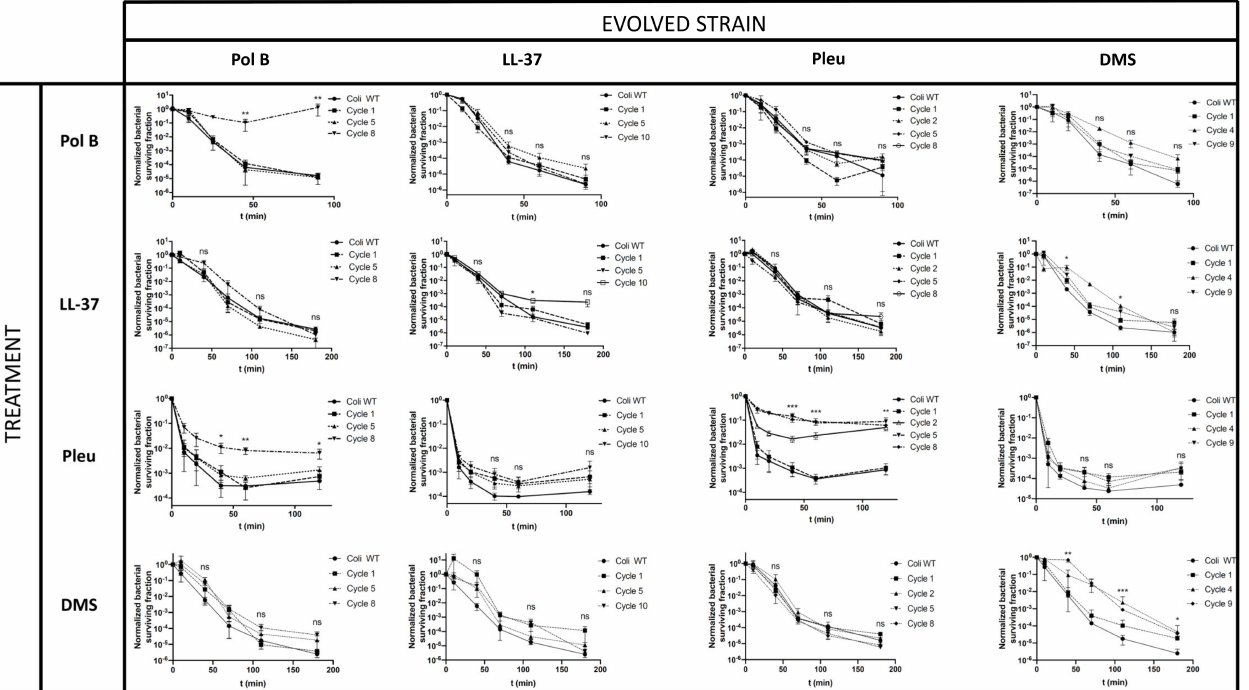
Figure 3. Killing curve assays for evolved strains against all tested AMPs. All combinations for evolved strains and AMPs were tested to detect cross-tolerance. The data are given as the relative surviving bacteria compared to the initial inoculum. Values are shown as the mean ± SEM, and all experiments were performed in triplicates. p -values are reported as indicated: ns: non-significant; * p < 0.05; ** p < 0.01; *** p <